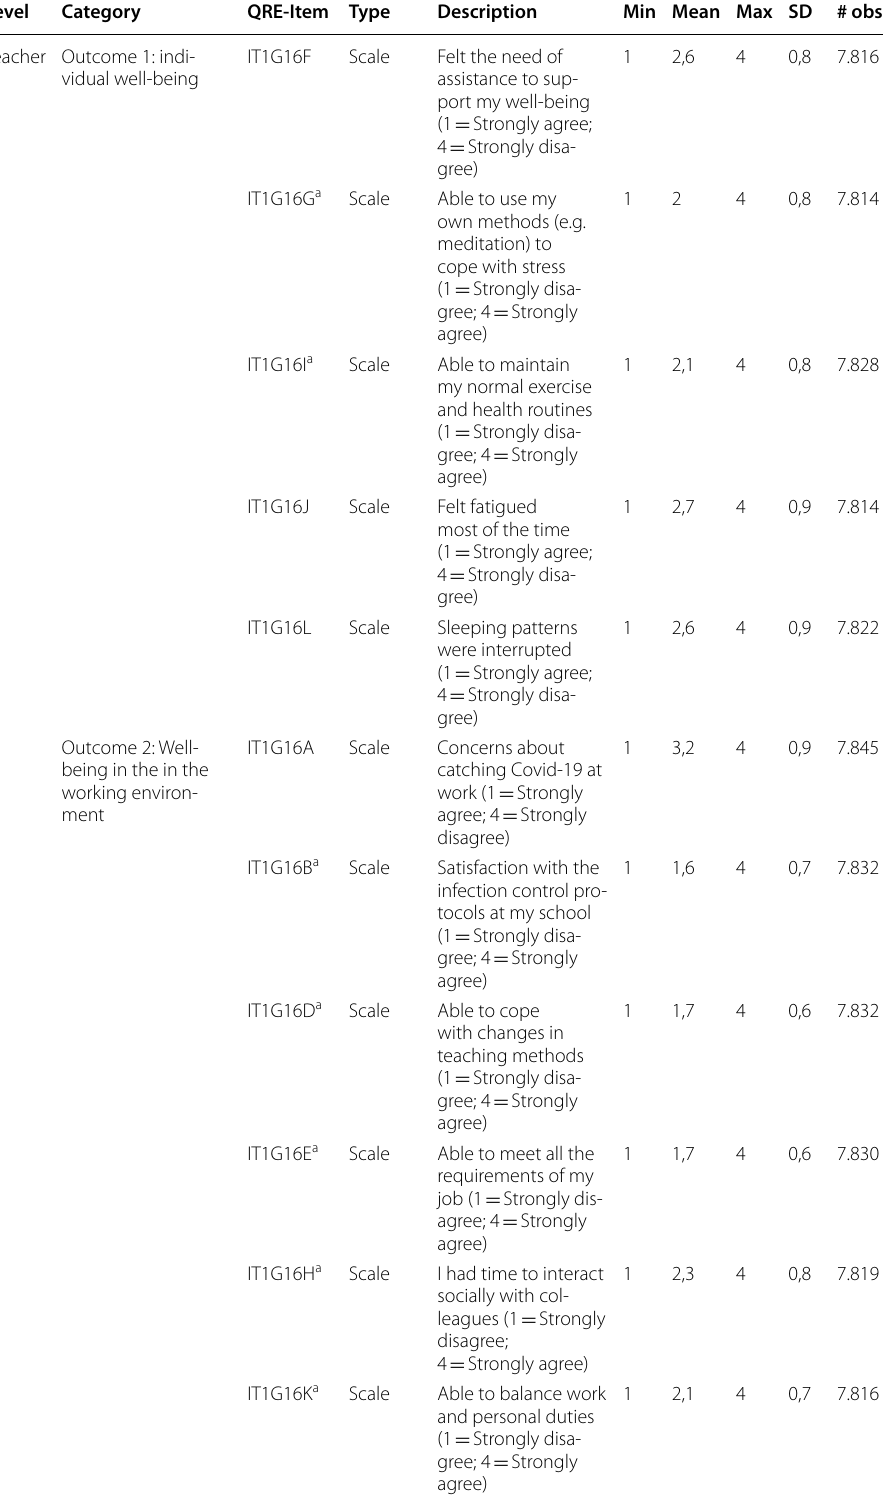
Table 1 REDS questionnaire items used to measure school effect on perceived individual (Outcome 1) and working environment well-being (Outcome